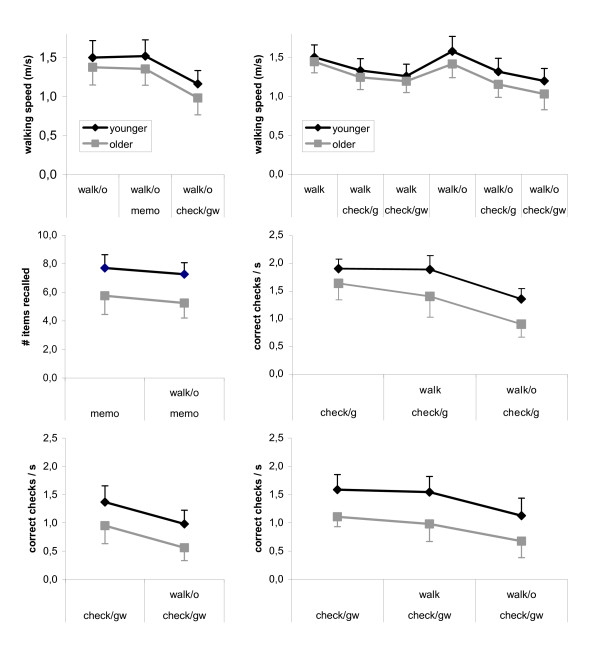
Subjects' performance on all constituent tasks of Exp. A (left) and B (right). Each symbol represents the average score of younger (black) or older (grey) subjects, and each error indicator the corresponding standard deviation.